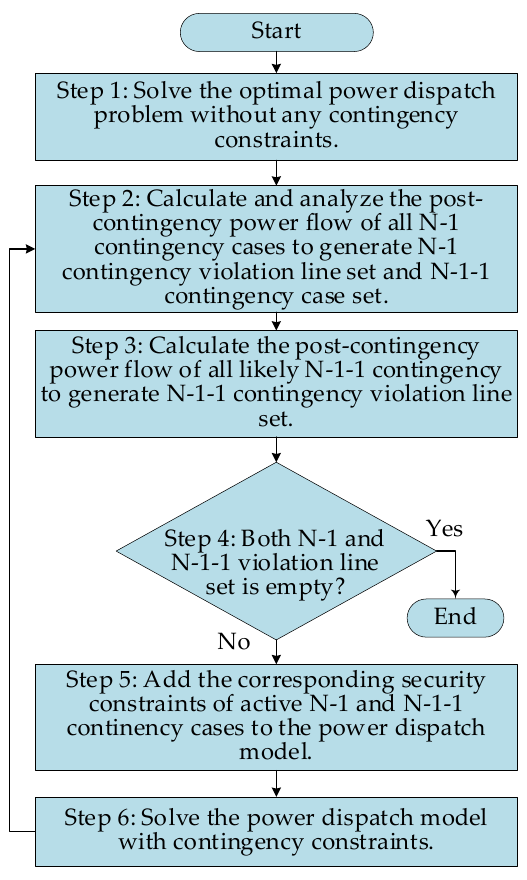
Figure 1. Flowchart of the proposed iterative contingency filtering process.